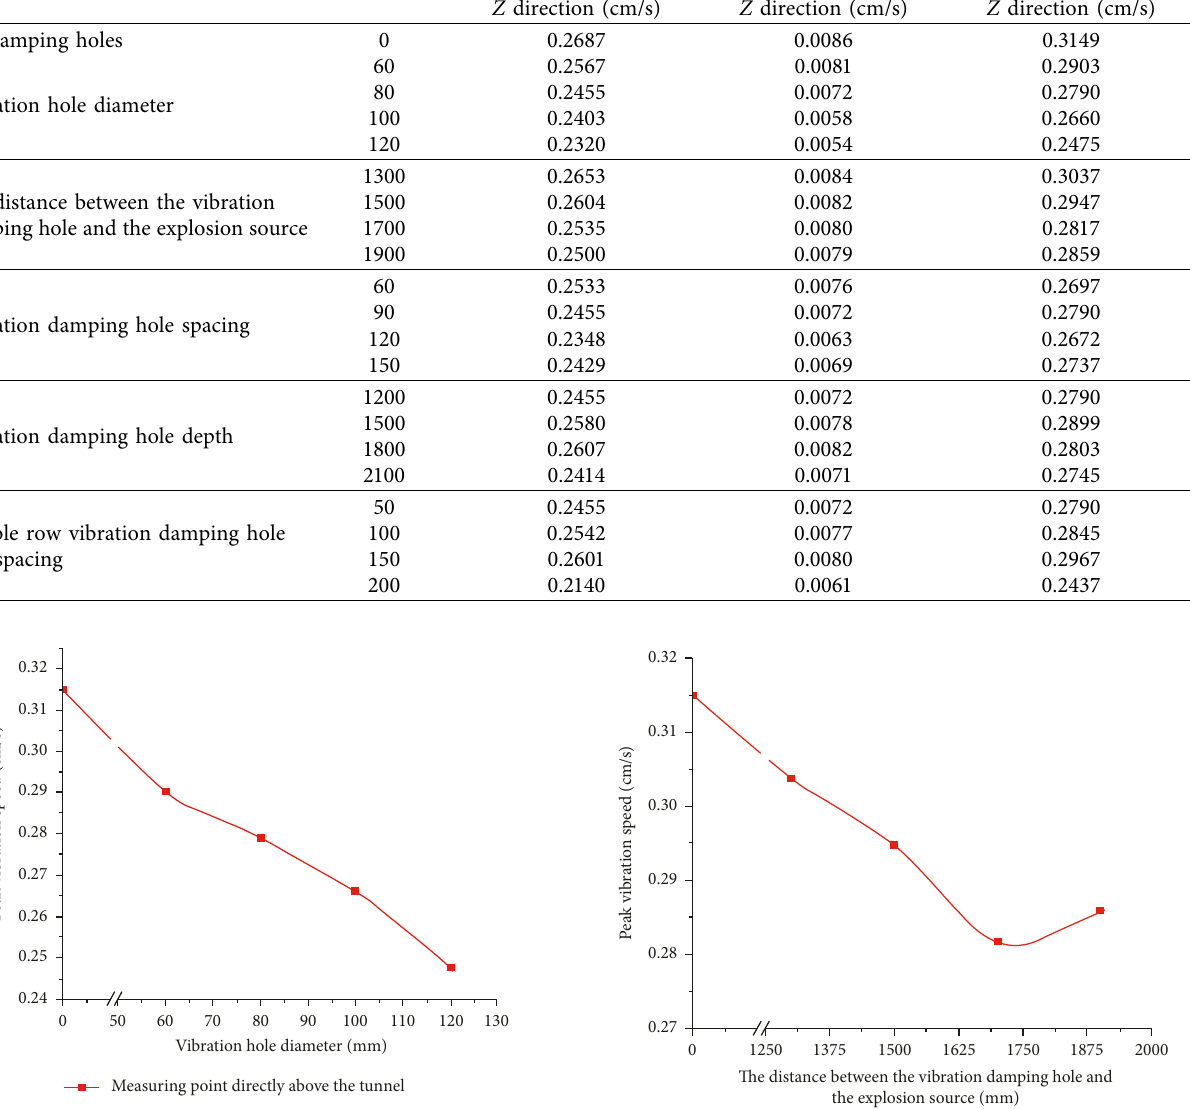
Figure 6: Peak vibration velocity of damping hole diameter.